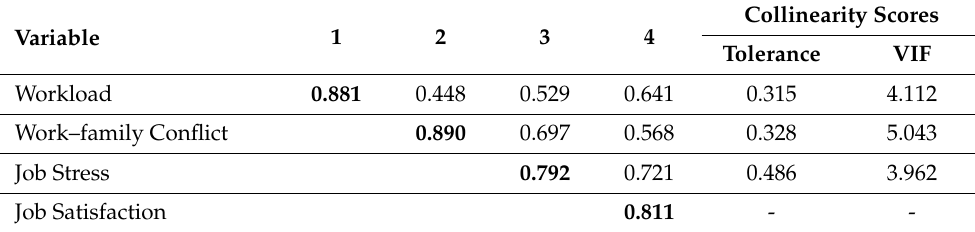
Table 6. Discriminant validity and collinearity diagnostic.